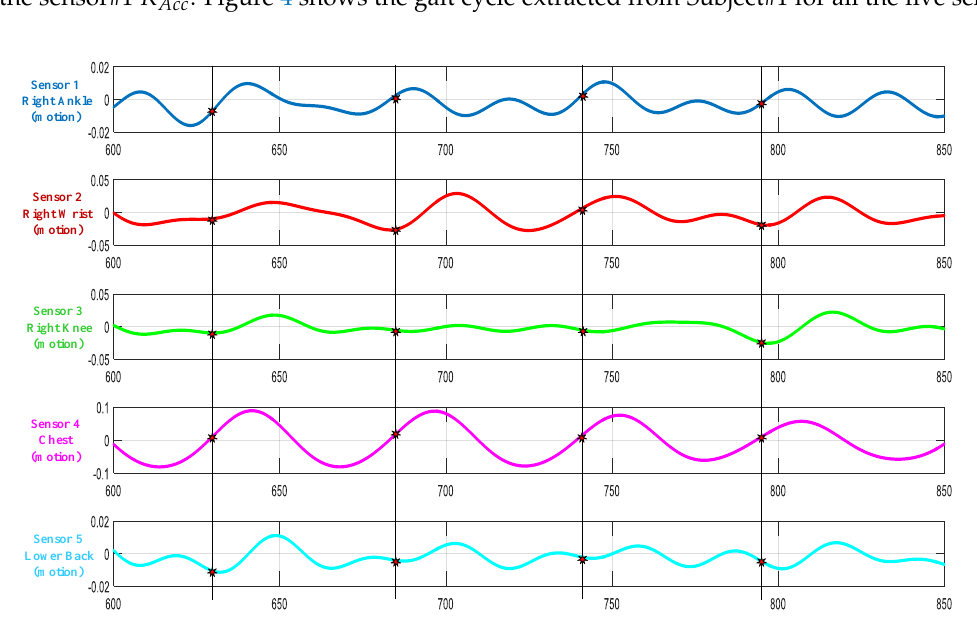
Figure 4. Extracted cycle data sample plot for subject 1 across all the